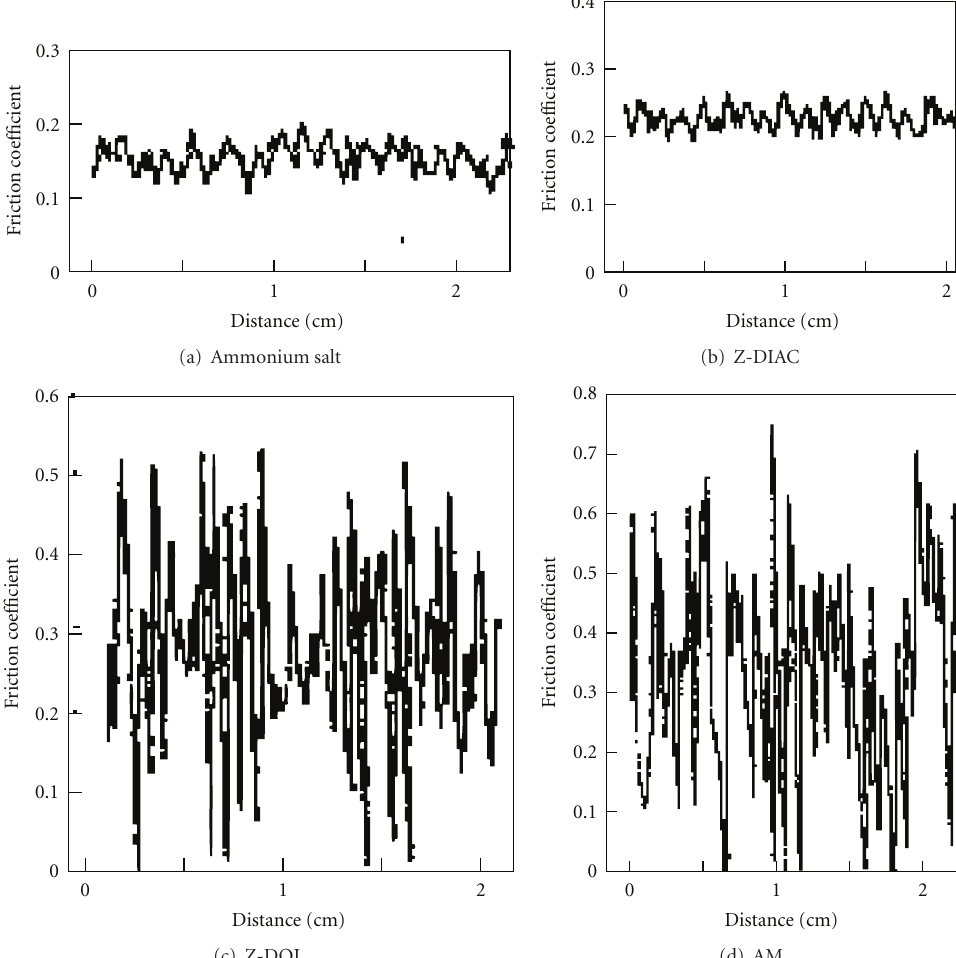
Figure 21: Change in dynamic friction coe ffi cient during the reciprocating operation for the di ff erent PFPEs.